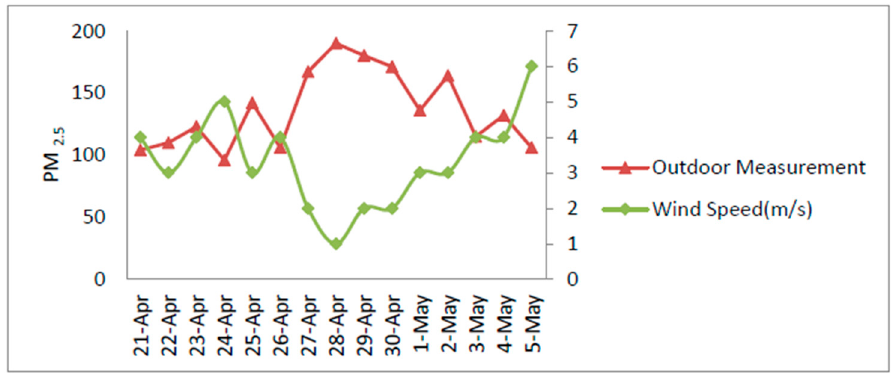
Figure 17. Effect of the wind speed on PM 2.5 concentration (microgram per cubic meter). Figure 18. Effect of the wind speed on PM 2.5 concentration (microgram per cubic meter).